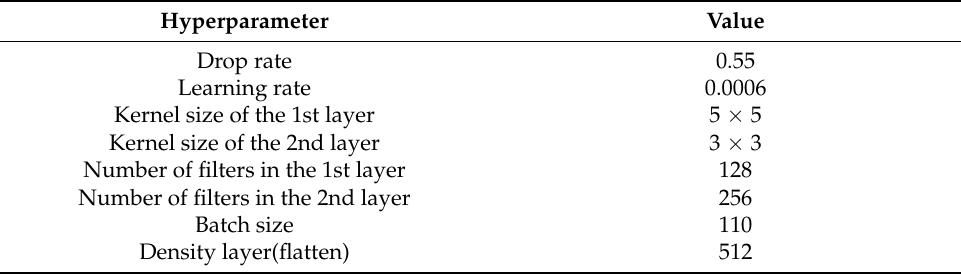
Table 1. Hyperparameters of